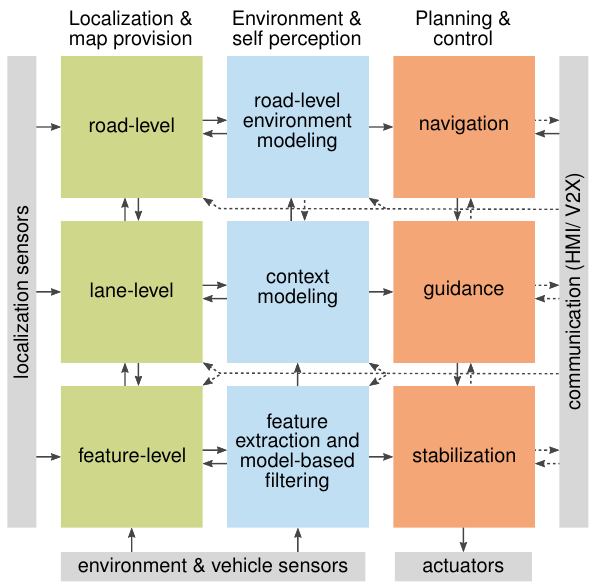
Figure 1. Functional system architecture of an automated vehicle proposed by Ulbrich et al., 2017 tical abstraction layers representing action planning (strategic layer, top row), maneuver decisions (tactical layer, middle row) and reactive action monitoring (operational layer, bottom row) (Ulbrich et al.,